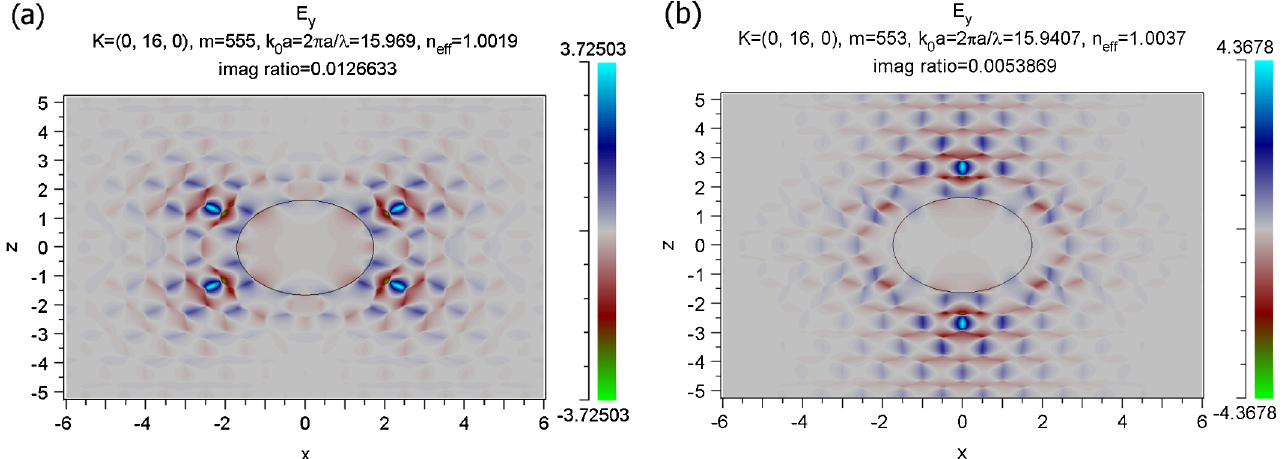
FIG. 19. Longitudinal electric fields of the two nearly degenerate TM surface modes crossing the light line for the HC-1060 fiber as a ¼ 16 . The solid ellipse denotes the boundary of the central defect hole. calculated with BANDSOLVE for a value of k z